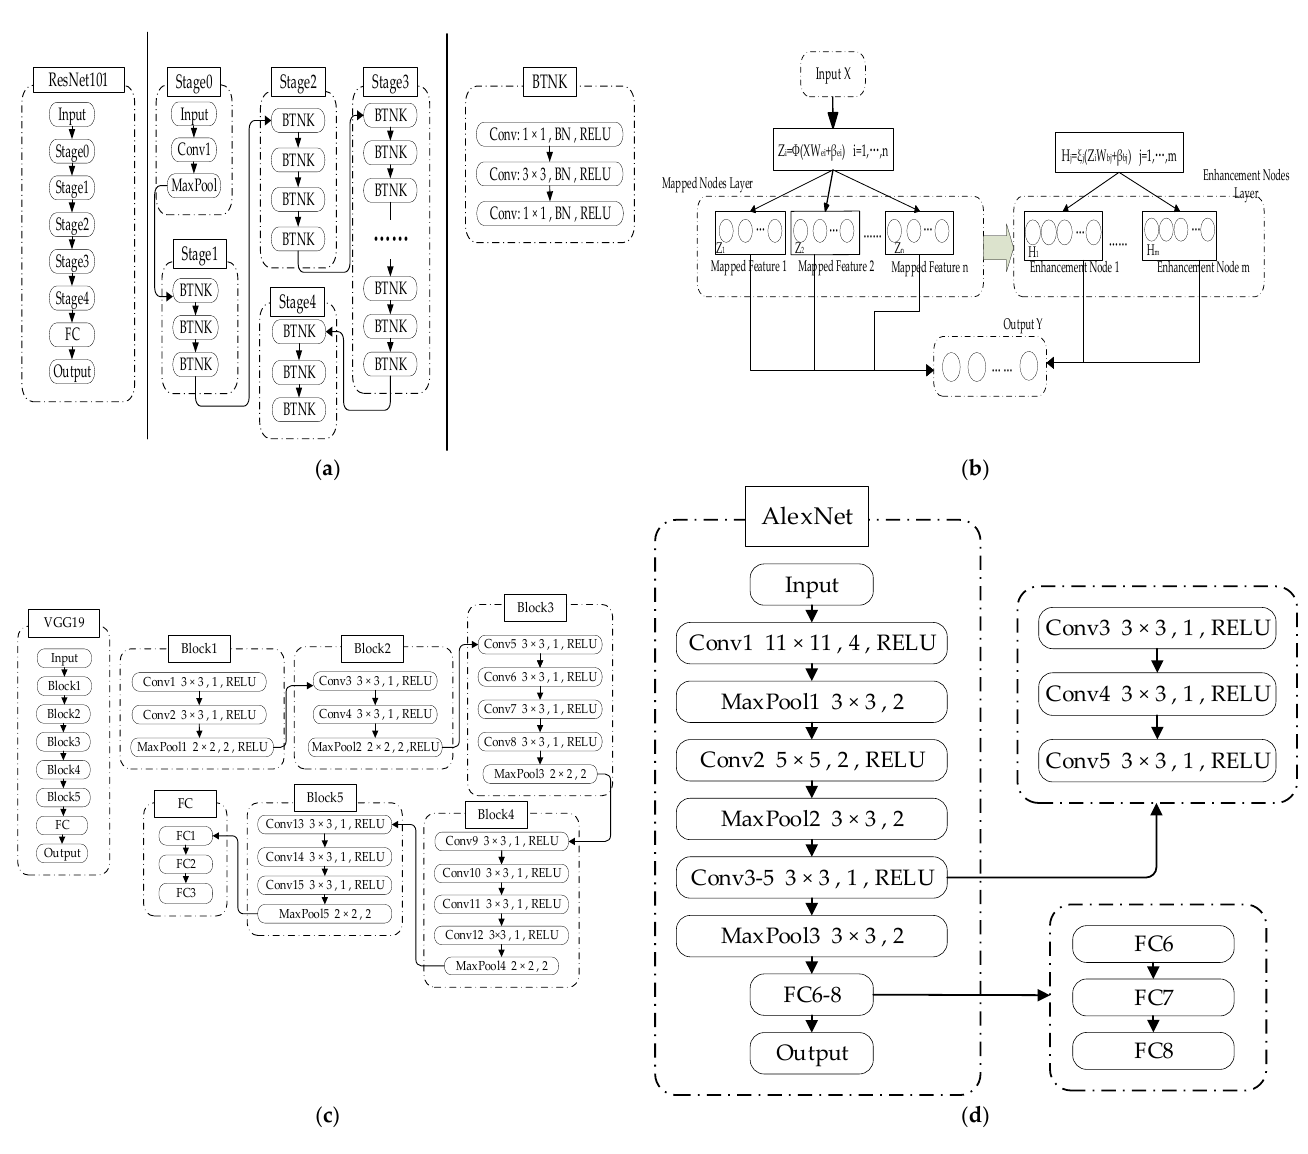
Figure 7. Structure of models. ( a ) Structure of ResNet; ( b ) structure of the CBNLM-BLS; ( c ) structure of VGG19; ( d ) structure of AlexNet.